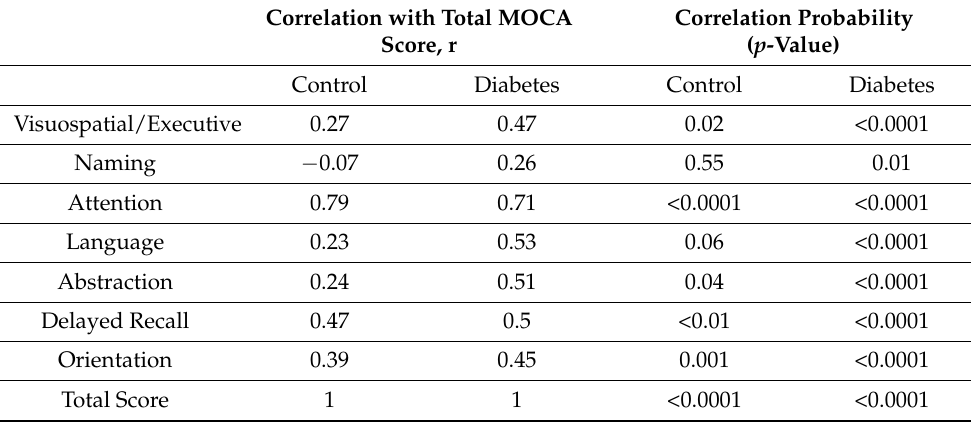
Table 6. Multivariate correlation